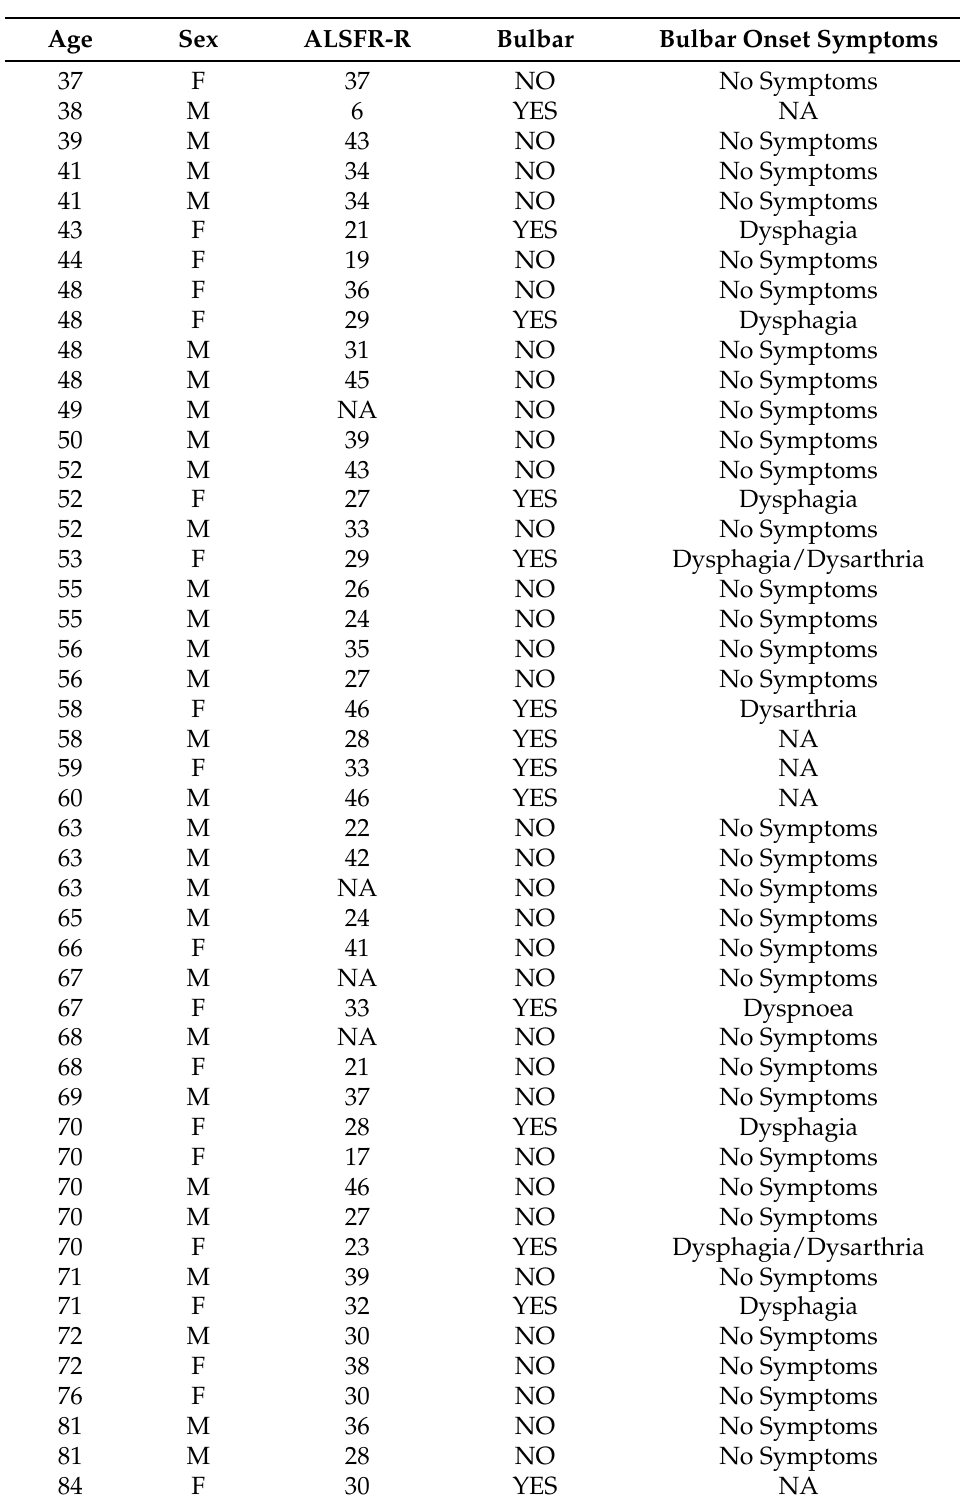
Table 1. ALS participants clinical records. Notation: Age (in years). ALSFR-R (Rating Scale-Revised): scores (0–48) the severity of ALS; Bulbar: Bulbar involvement; NA: Data not